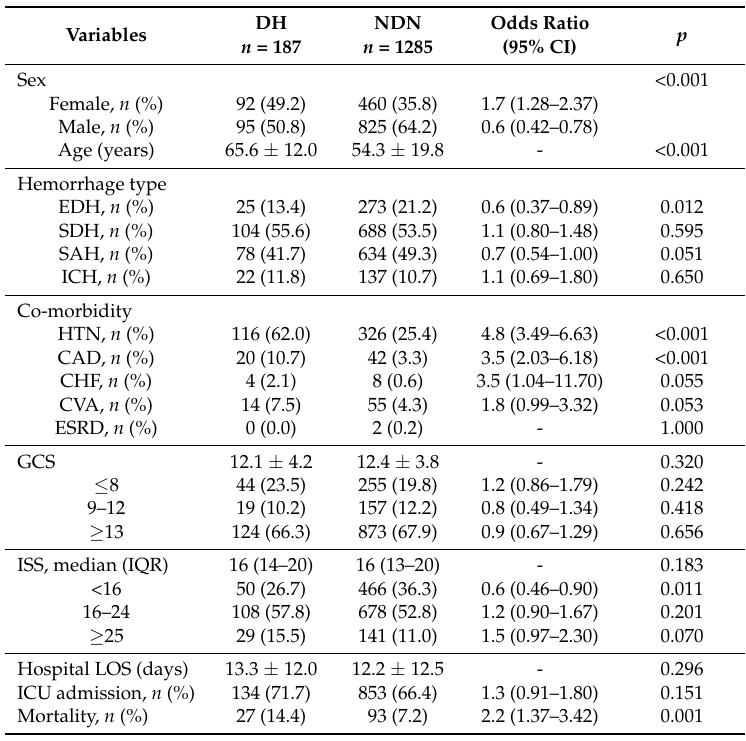
Table 2. Comparison of the characteristics and outcomes of the DH and NDN groups of